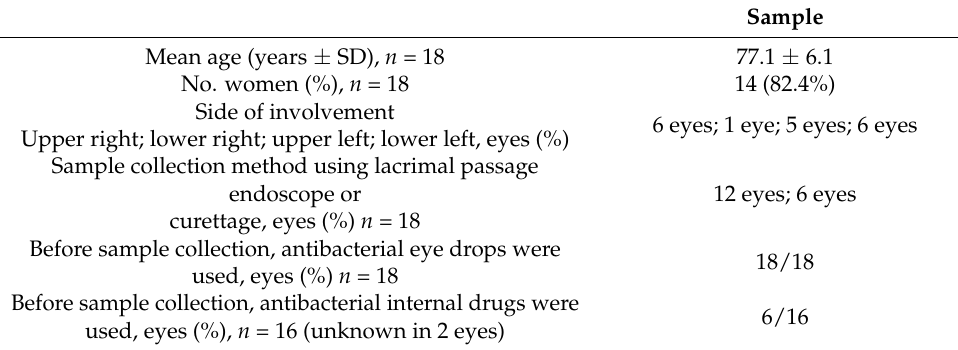
Table 1. Patient